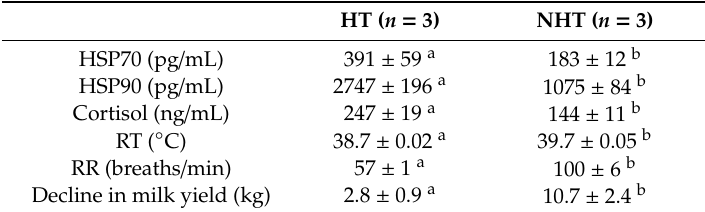
Table 1. Comparison of heat stress indexes between heat tolerant (HT) and non-heat tolerant (NHT) Chinese Holstein dairy cows (M ± SEM).